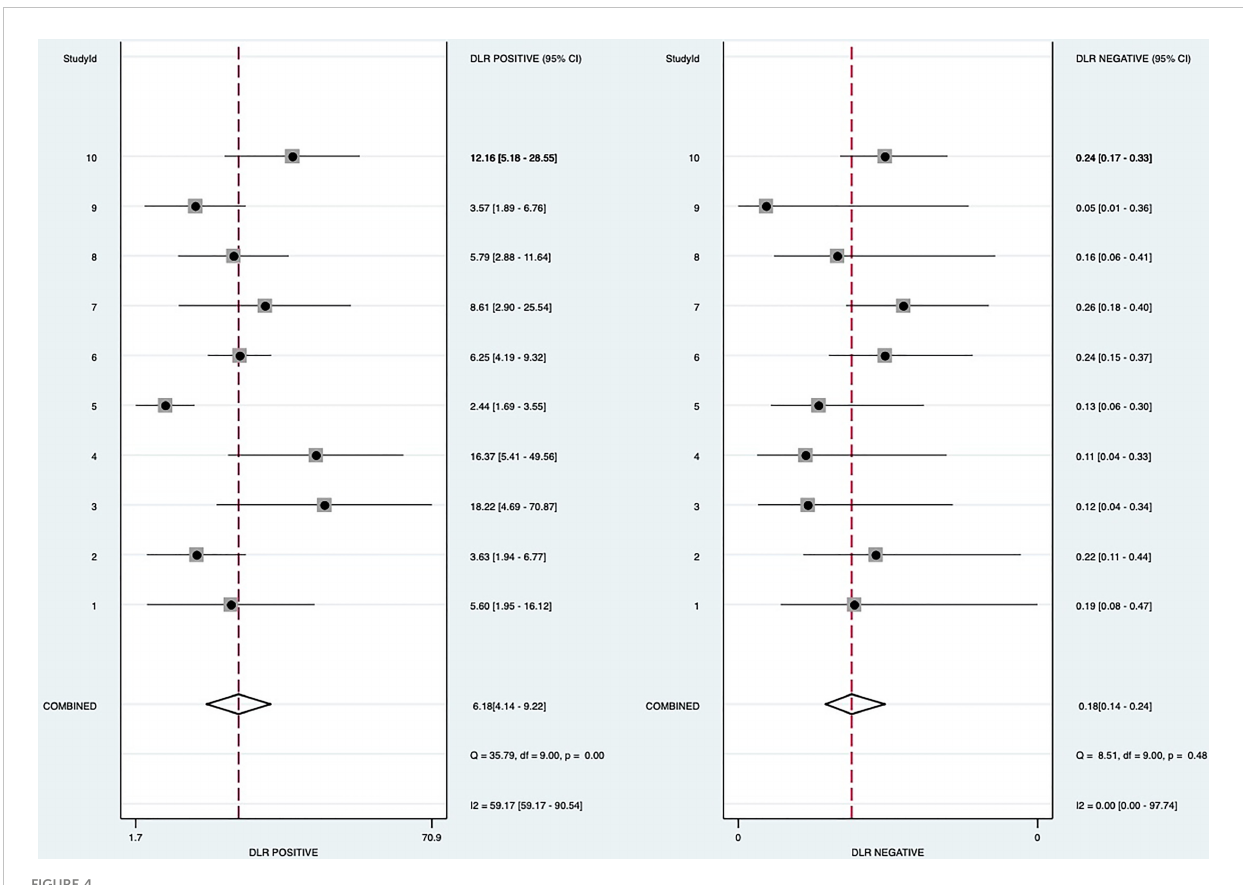
FIGURE 4 Forest plot for Positive likelihood ratio and negative likelihood